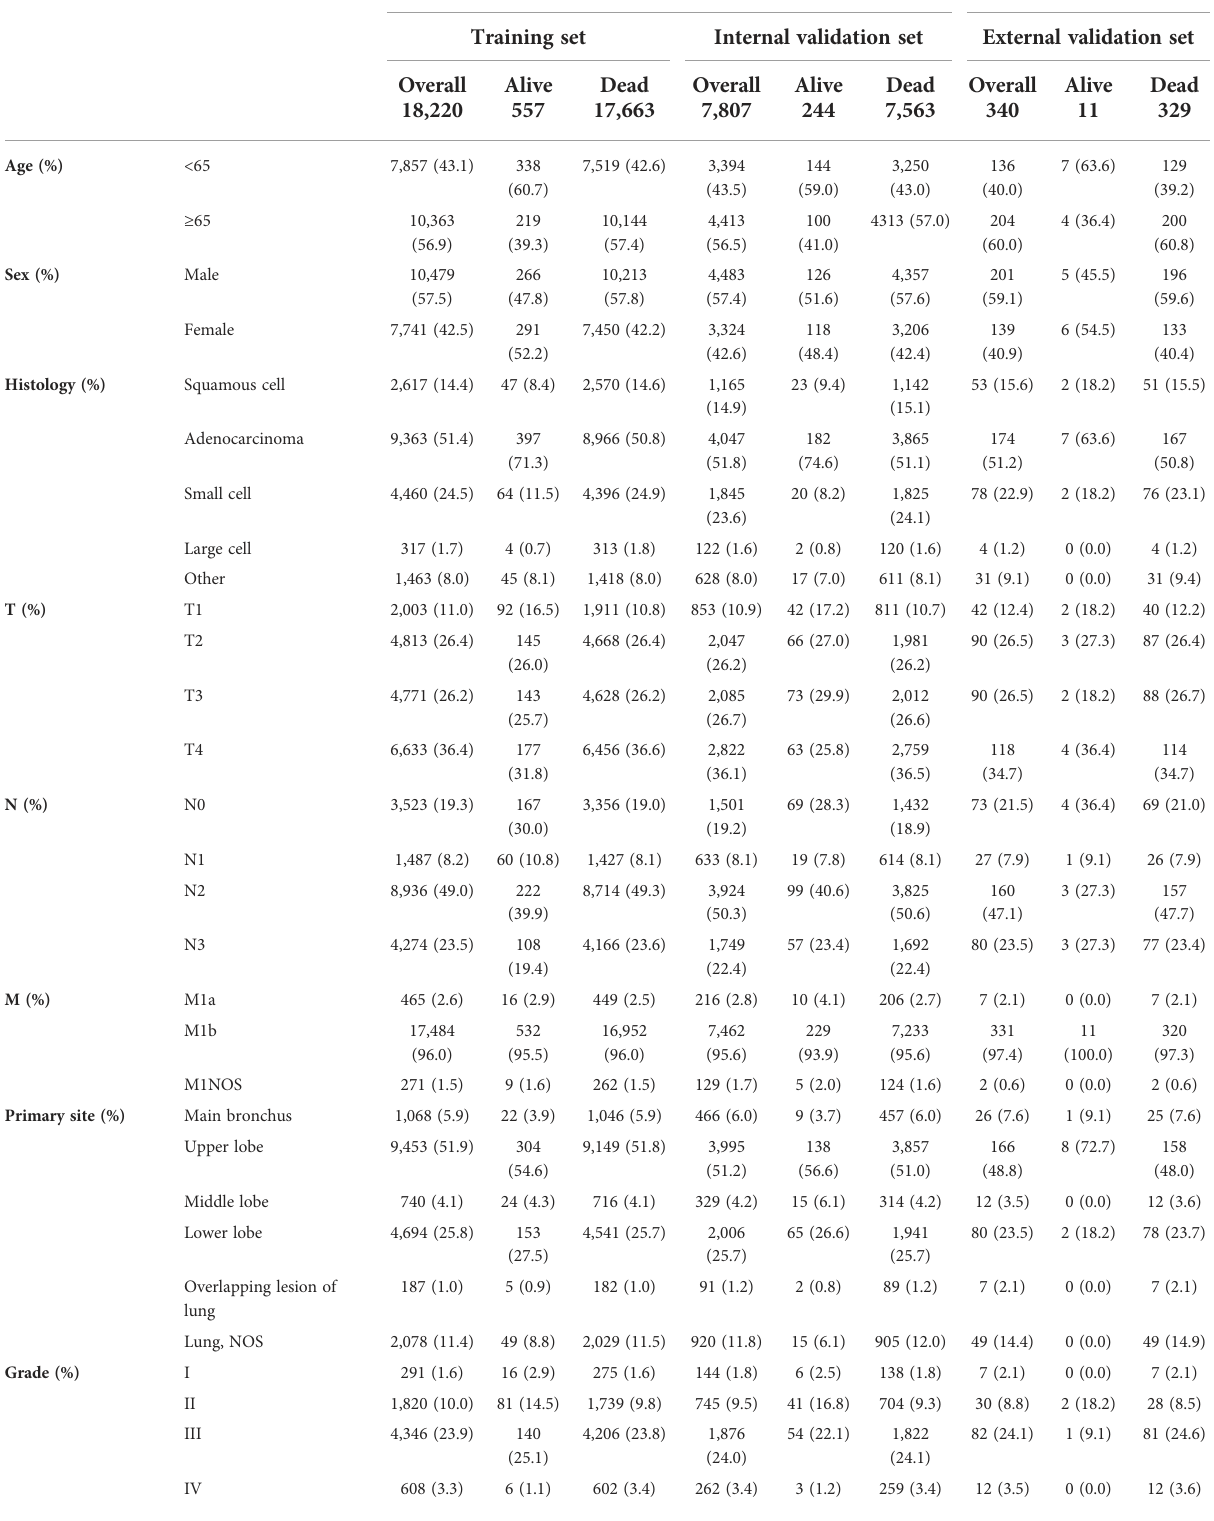
TABLE 1 Demographic and clinicopathological characteristics of patients in the training, internal validation, and external validation cohorts (N, %).